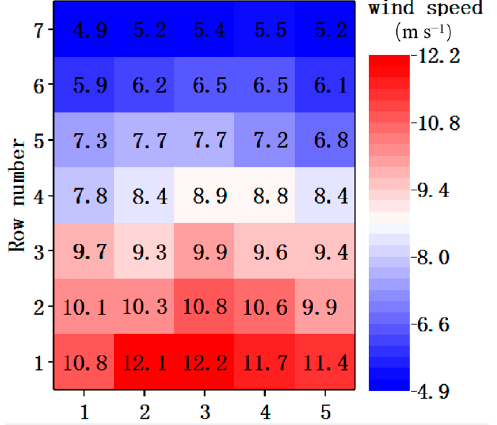
Figure 8. Grid of wind inlet velocities.